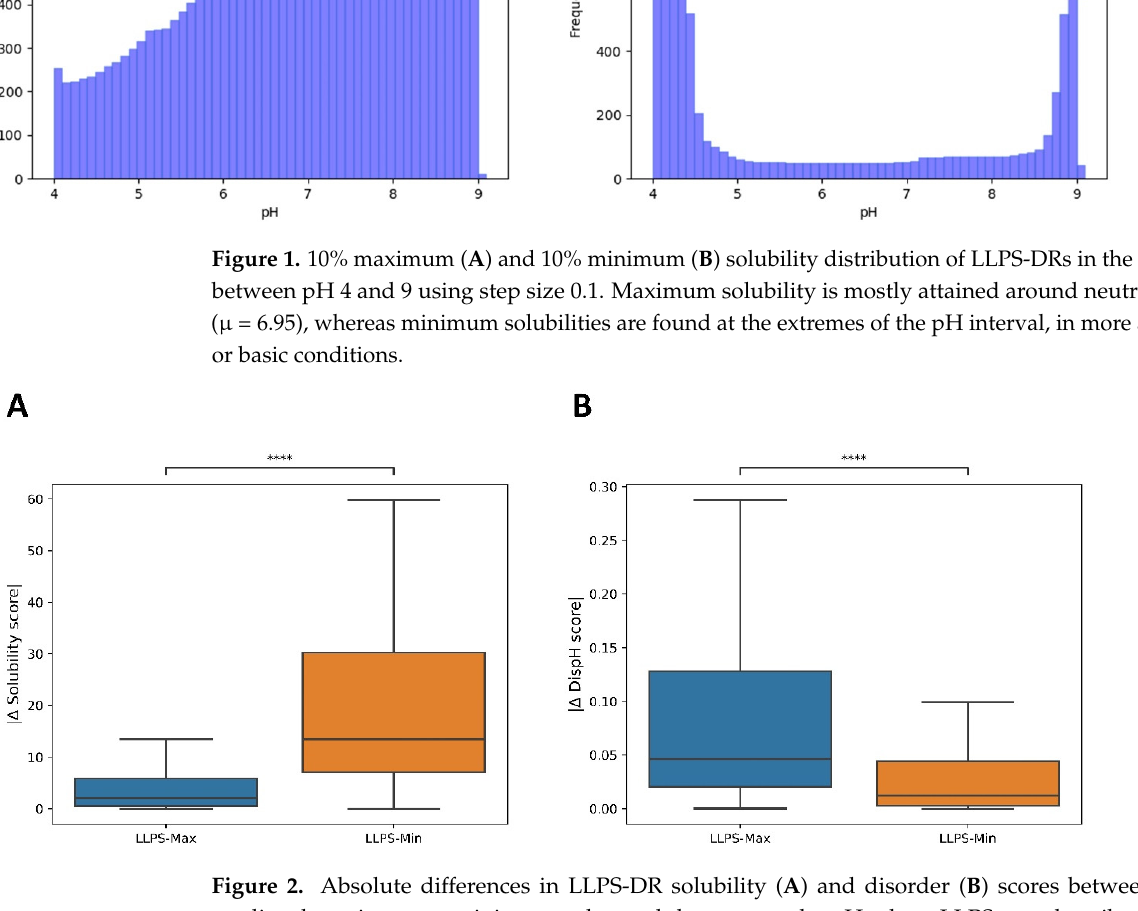
Figure 2. Absolute differences in LLPS-DR solubility ( A ) and disorder ( B ) scores between the predicted maximum or minimum value and the score at the pH where LLPS was described. pH conditions in LLPS buffers are closer to LLPS-DR maximum solubilities ( p = 6.080 × 10 − 31 ) and minimum DispH scores ( p = 3.905 × 10 − 15 ). Four asterisks (****) indicate p ≤ 0.0001.